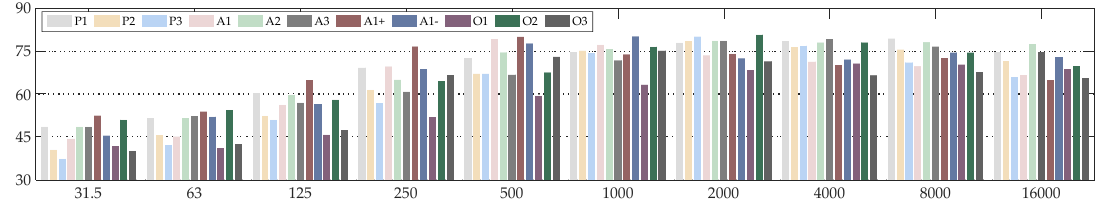
Figure 4. Comparison of the octave frequency bands for the eleven hand configurations.